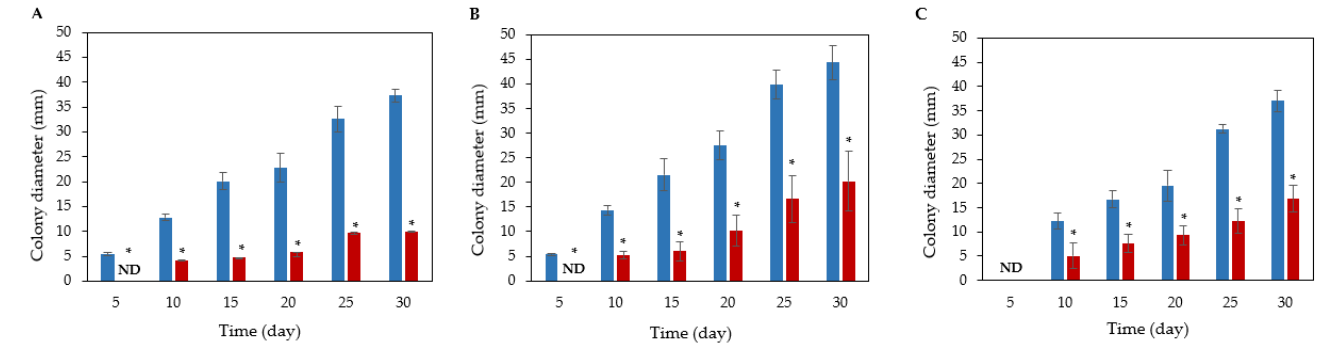
Figure 5. Effect of whey – gelatin films incorporated with L. brevis SJC120 and applied to cheese on fungal growth (mm) of ( A ) P. brevicompactum , ( B ) P. commune , and ( C ) P. nordicum for 30 days at 10 °C. The blue bars represent control films (without LAB), and the red bars represent L. brevis SJC120 films. Values are the mean ± SEM ( n = 3). * p < 0.05 versus control. ND: not detected (no fungal growth observed).